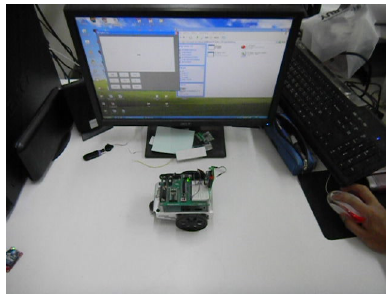
Figure 17. Surrounding environment of the first test.